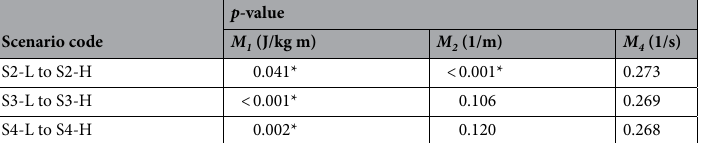
Table 4. p-values from a t-test associated with changes in flow rate for a given boulder concentration. M 1 is the kinetic energy gradient metric, M 2 is the normalized kinetic energy gradient metric, and M 4 is the modified recirculation metric. (*) indicates the change is statistically significant assuming a significance level of 0.05.